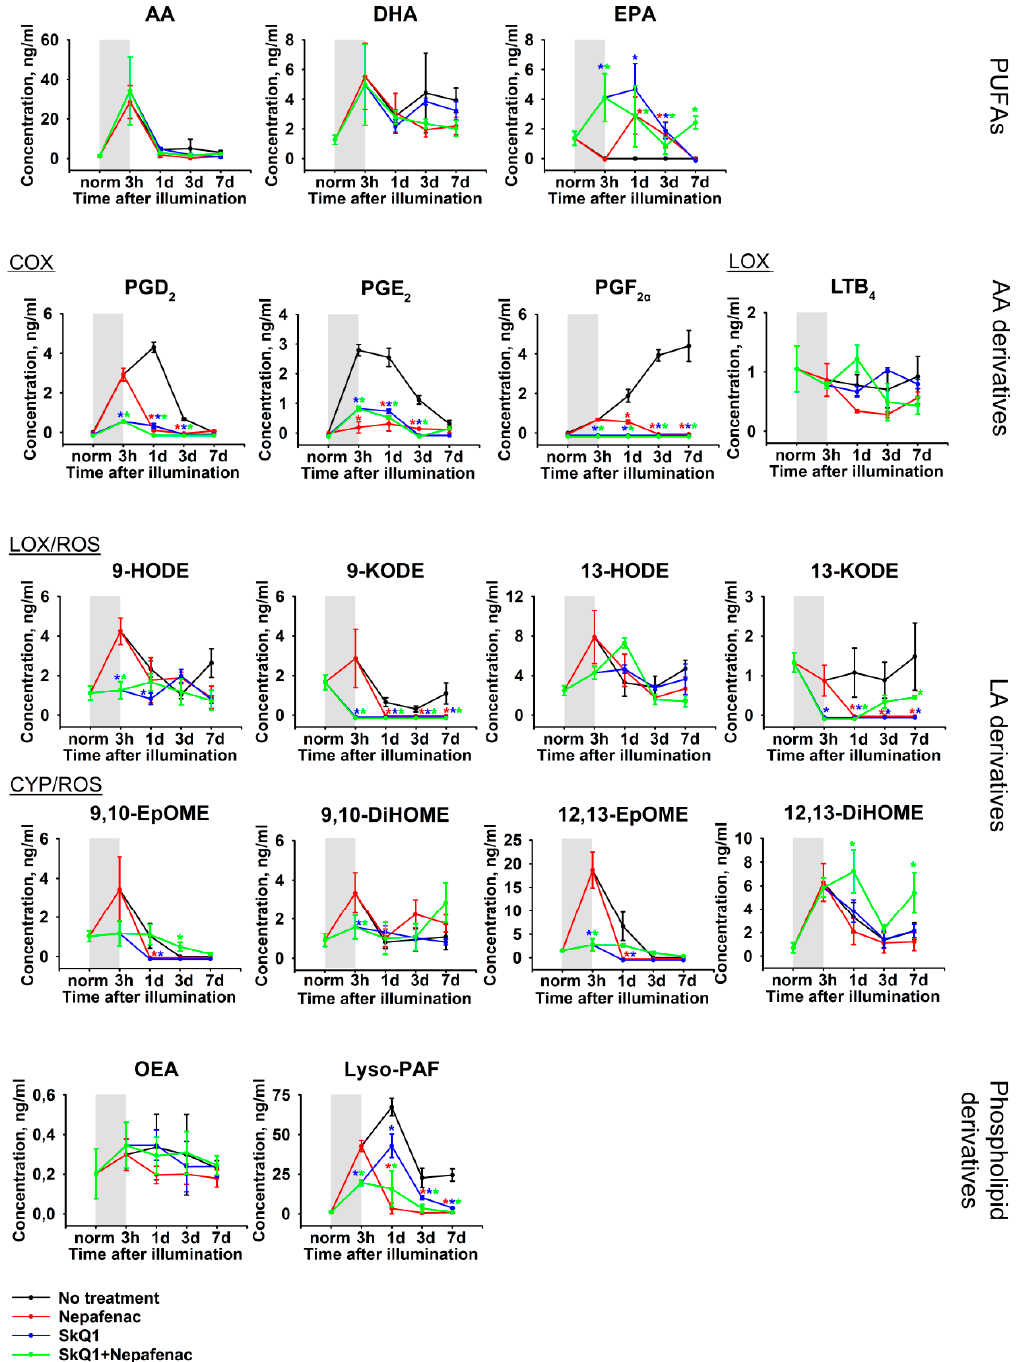
Figure 8. Alterations in patterns of lipid mediators in rabbit AH under conditions of LIRD without treatment (black), in the course of treatment with Nepafenac (red), after premedication with SkQ1 (blue), and in the course of the therapy using the combination of the both drugs (green). The animals were illuminated with intense visible light (30,000 lx) for 3 h (the course of the illumination is shown as gray box). The AH samples were colected before (norm) and immediately after (3 h) the illumination as well as on 1, 3, and 7 day post-exposure. The concentrations of the lipid mediators (phospholipid derivatives, PUFAs and oxylipins) in AH were measured using quantitative UPLC-MS/MS analysis. * p >0.05 as compared to the parameters of AH of the untreated illuminated animals. The identified oxylipins are divided into subgroups according to their origin and biosynthetic pathways, involving COX, LOX, CYP, or ROS (non-enzymatic pathway).